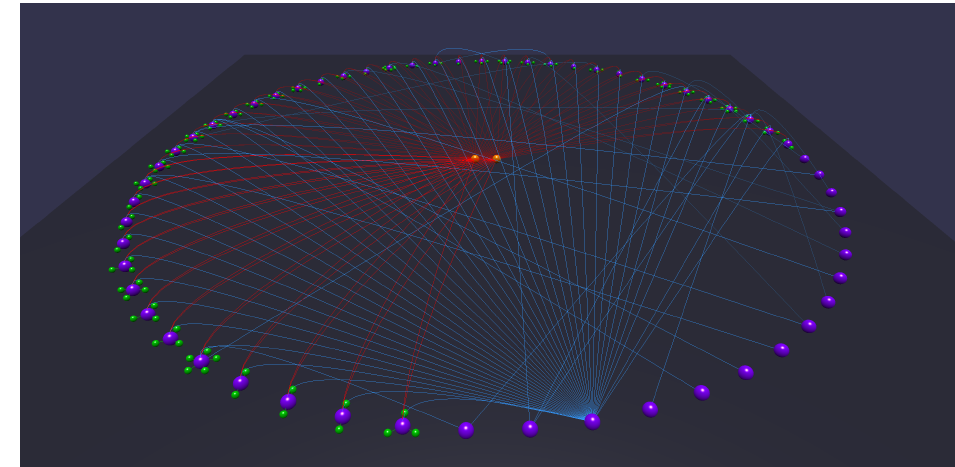
Figure 10. Visualization of the graph extracted from DBpedia (Use Case #2), containing all the artists born in Bologna between 1000 AD and 2000 AD and people who inspired